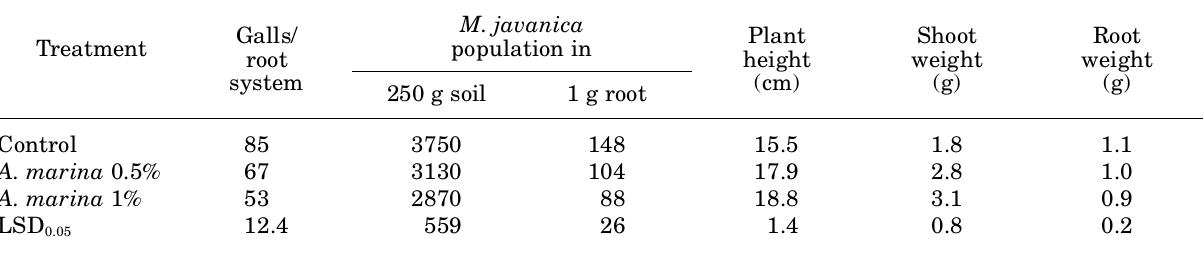
Table 1. Effect of soil amended with powdered leaves of Avicennia marina on Meloidogyne javanica populations in the soil and in the roots of mungbean, and its effect on the growth of mungbean.